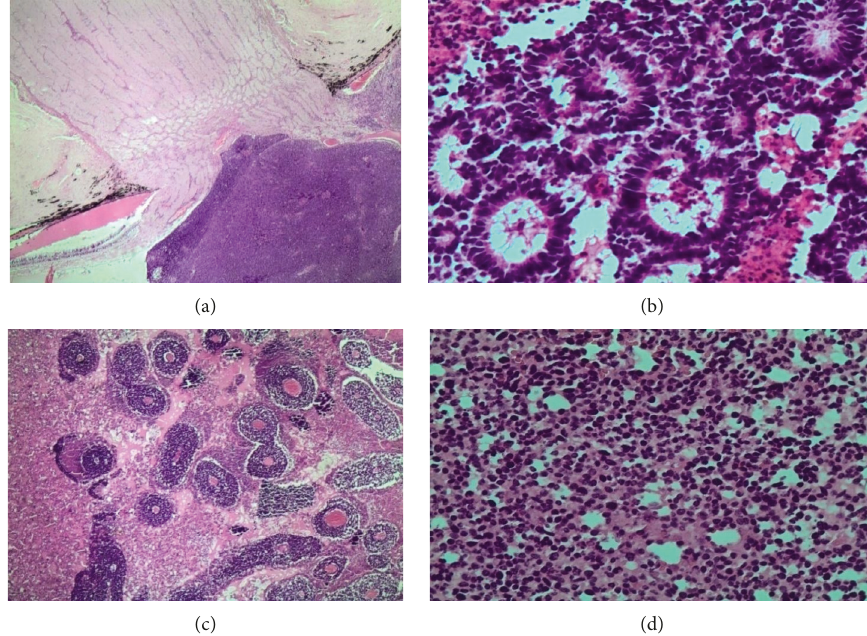
Figure 3: (a) Lamina cribrosa optic nerve invasion. (b) Tumour with Flexner–Wintersteiner rosettes. (c) Tumour with pseudorosettes. (d) Poorly differentiated.